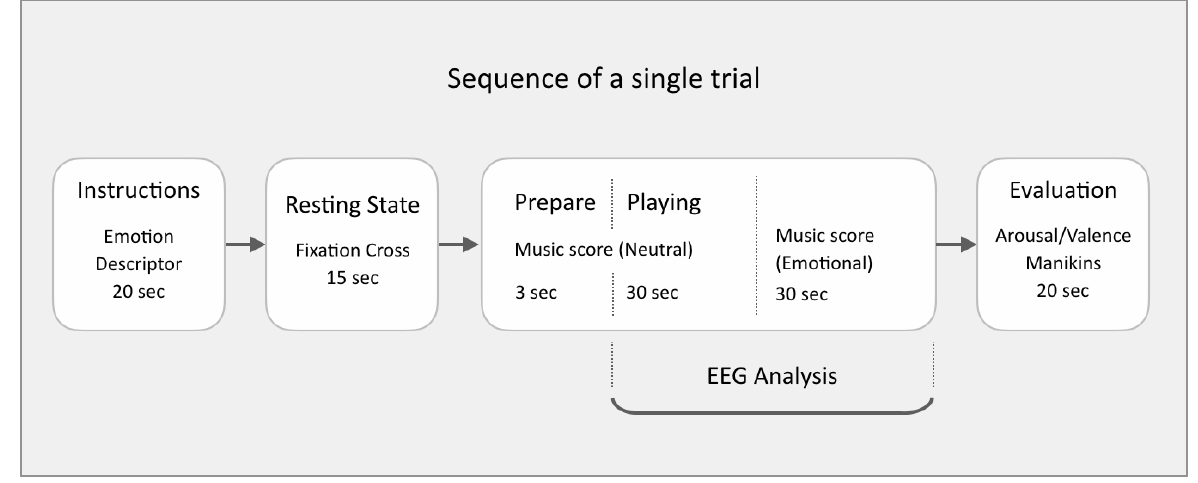
Figure 1. Sequence of a single experimental trial.